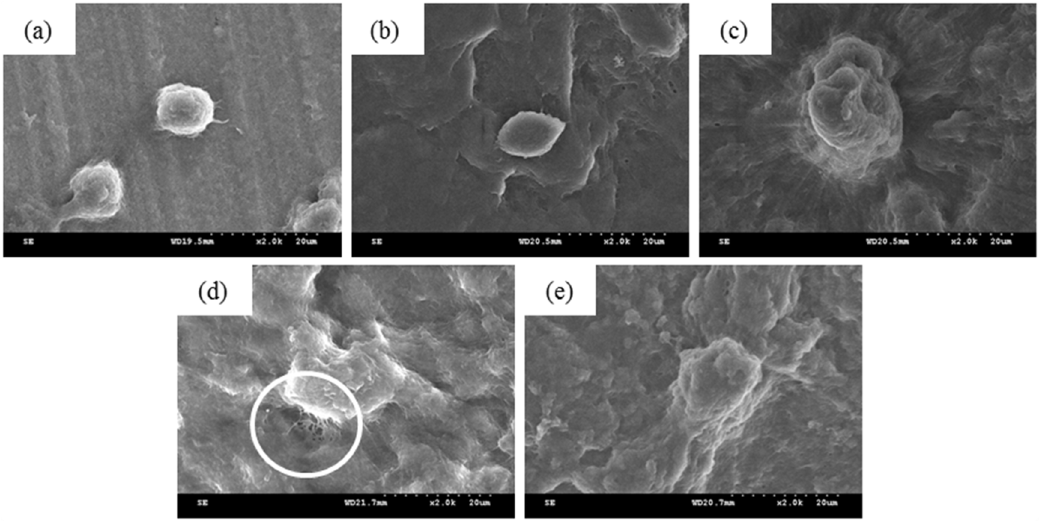
Figure 9. Cell attachment of PVA/zinc citrate nanofiber mats that contain ( a ) 0 wt %; ( b ) 0.5 wt %; ( c ) 1 wt %; ( d ) 3 wt %; and ( e ) 5 wt %.